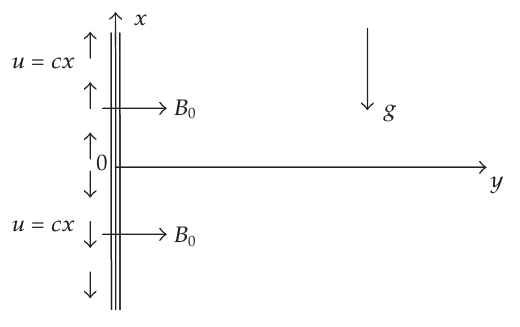
Figure 2.1 . Sketch of the physical